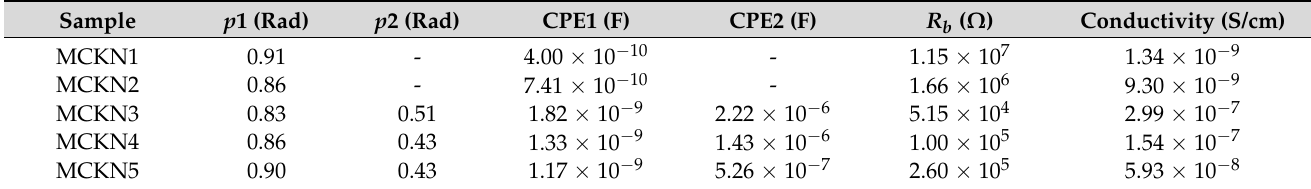
Table 1. Bulk resistance and circuit elements for MC:KSCN SPE films.